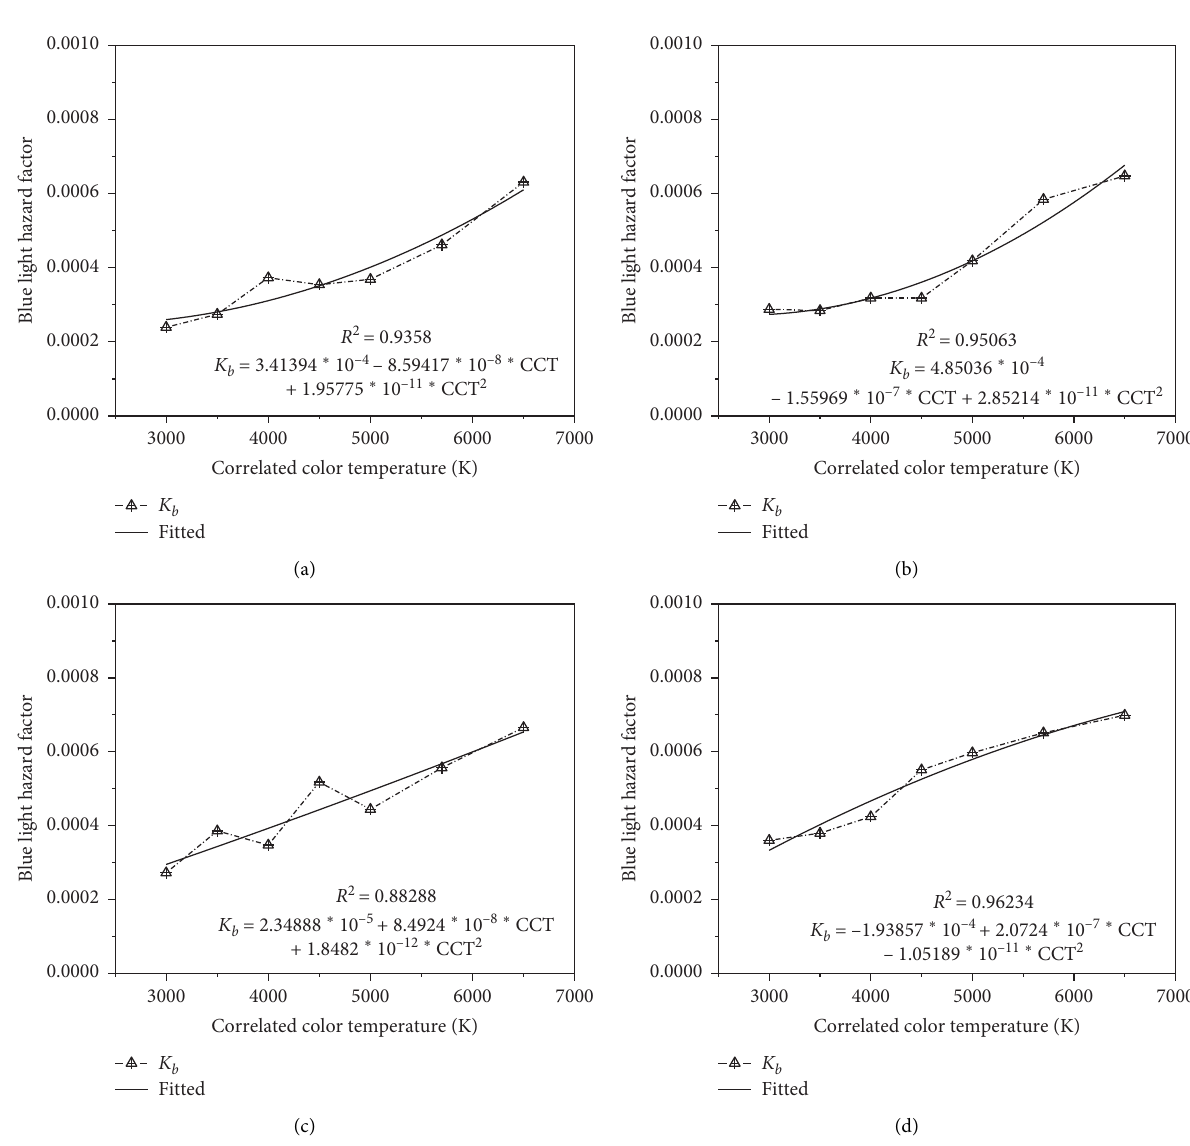
Figure 9: Observation targets.